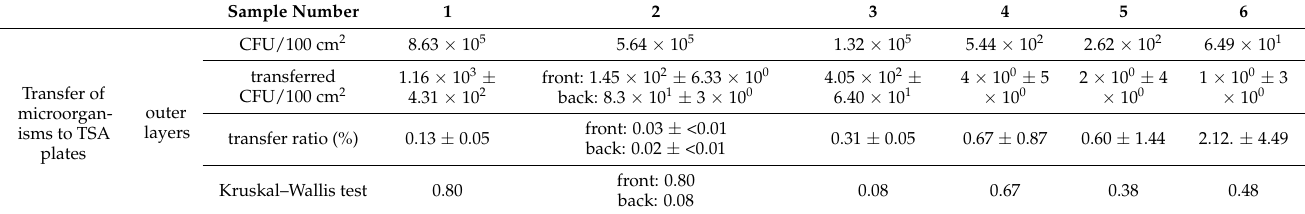
Table 3. Transfer of microorganisms from samples to tryptone soy agar (TSA) plates tested with different applied weights. The samples are labeled with respect to their numbers of colony-forming units per 100 square centimeters (CFU/100 cm 2 ) in descending order (1–6). The experimental set-up was performed as described in Figure 2(1). Data are shown as mean ± SD. The transfer ratios are declared as a percentage (%). A p -value of <0.05 was defined as statistically significant.